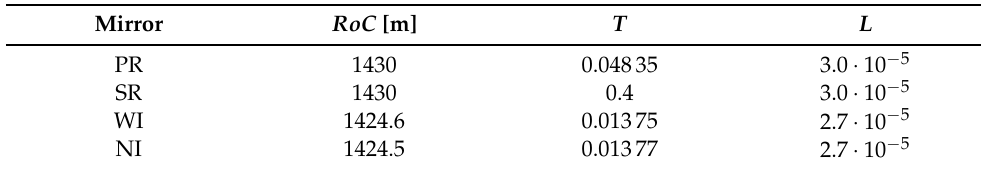
Table A1. Parameters of the mirrors of the simulated DRMI.